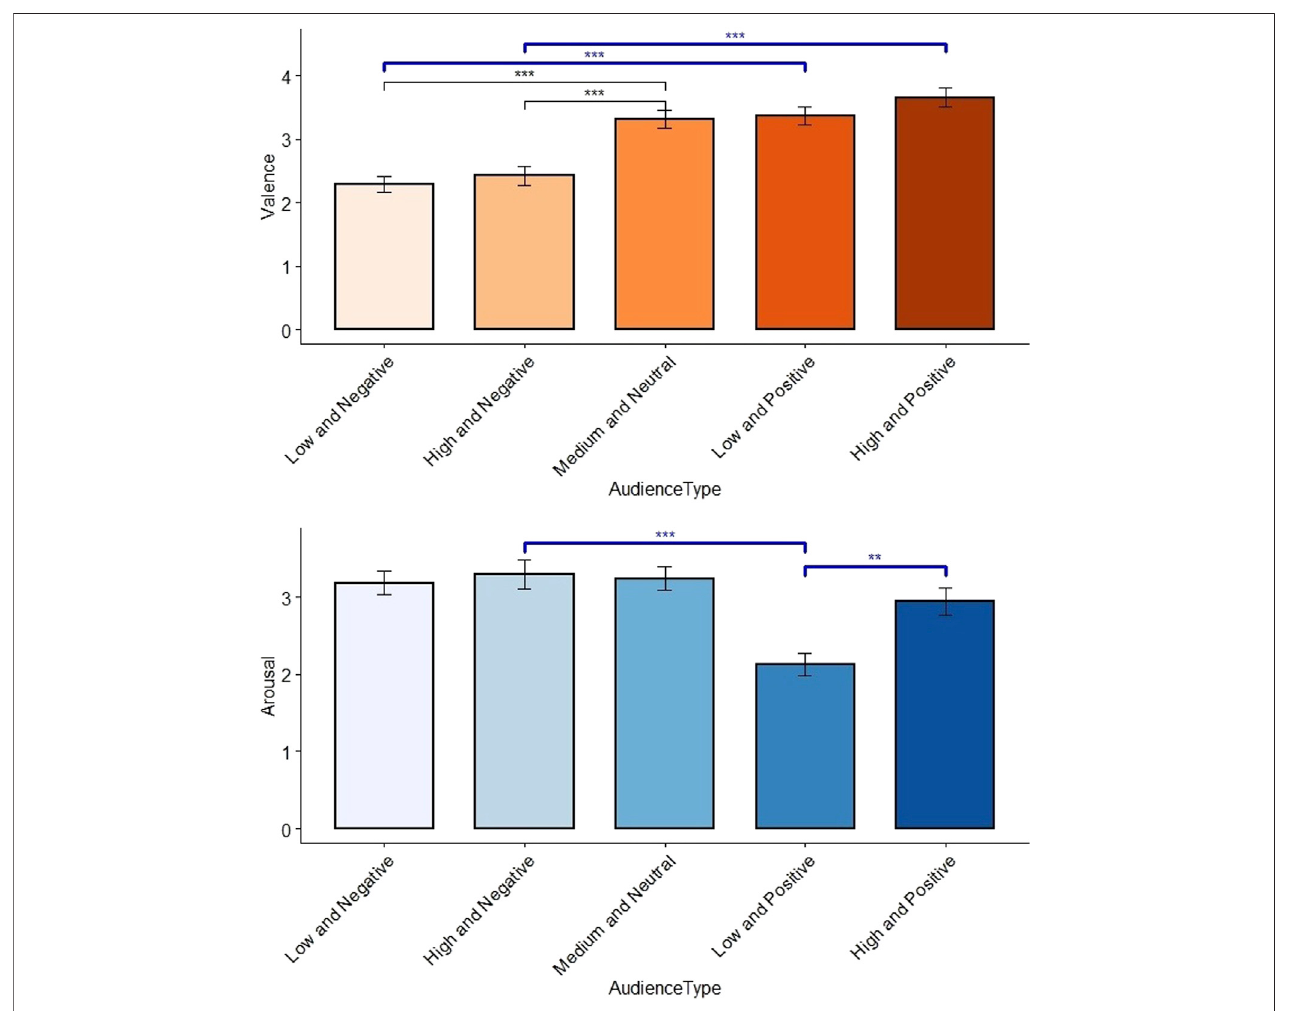
FIGURE 9 | Distribution plot of the selected valence and arousal depending on the attitudes. Main signi fi cant results from the pairwise tests for our hypotheses are shown in blue above the bars charts.